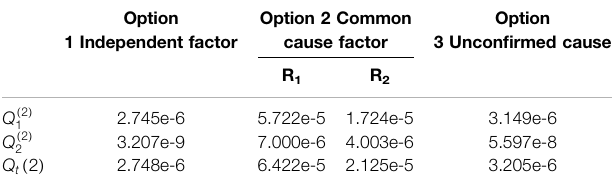
TABLE 2 | Results of three CCF treatment options if a component is unavailable ( i (cid:2) 1, t (cid:2) 120